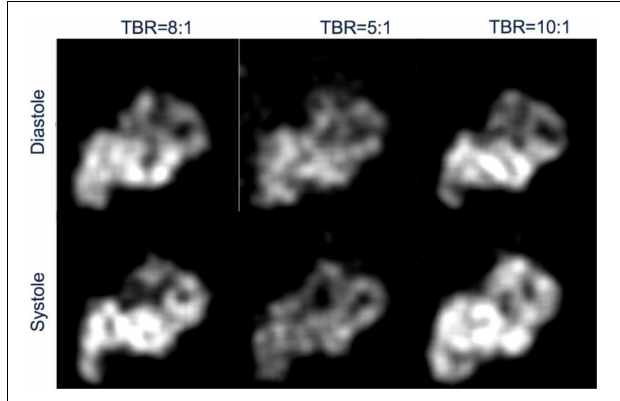
FIGURE 9 | Reconstructed image of myocardial activity distribution during diastole and systole phases of the heart for three different TBRs at full